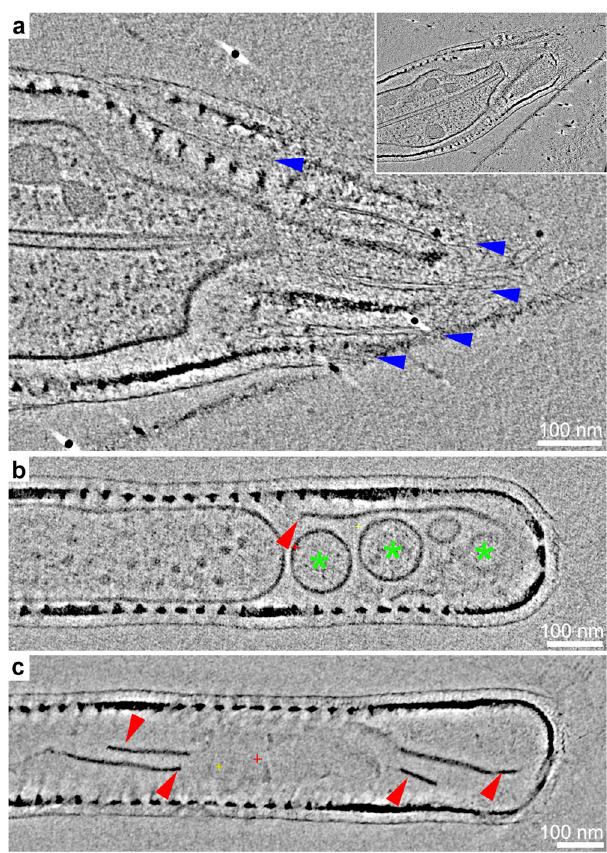
Fig. 4 Structural properties of damaged and long setae. Slices in the reconstructed volumes of: a A damaged short seta (inset shows lower magni fi cation). Blue arrowheads point to fi brous material that is aligned with the disrupted silica rods; b , c Long setae at different stages of cytoplasm degradation. Green asterisks indicate fragmented cytoplasm and red arrowheads indicate irregular sheet-like